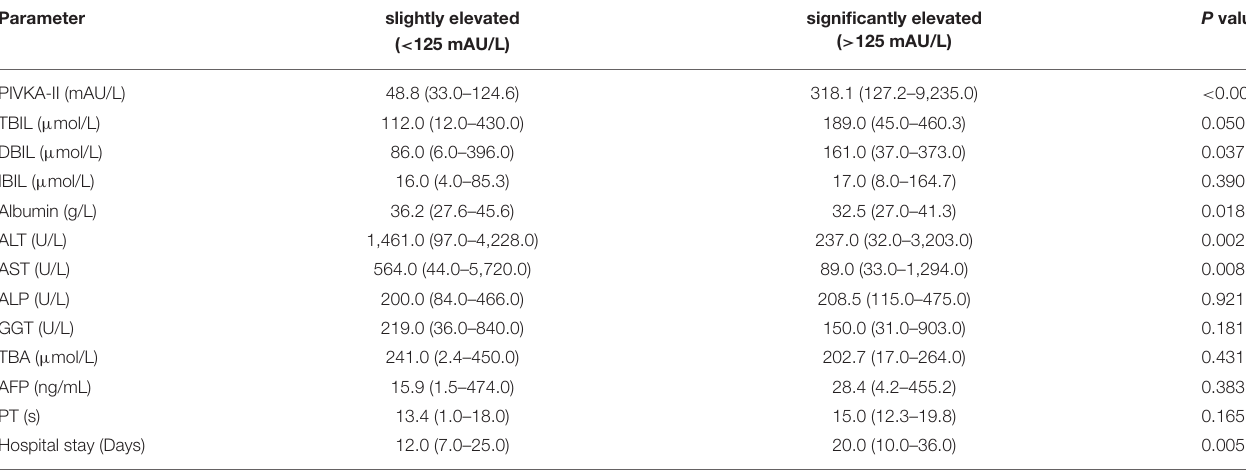
TABLE 2 | Association between clinical biochemical indexes and degree of elevated PIVKA-II. Parameter slightly